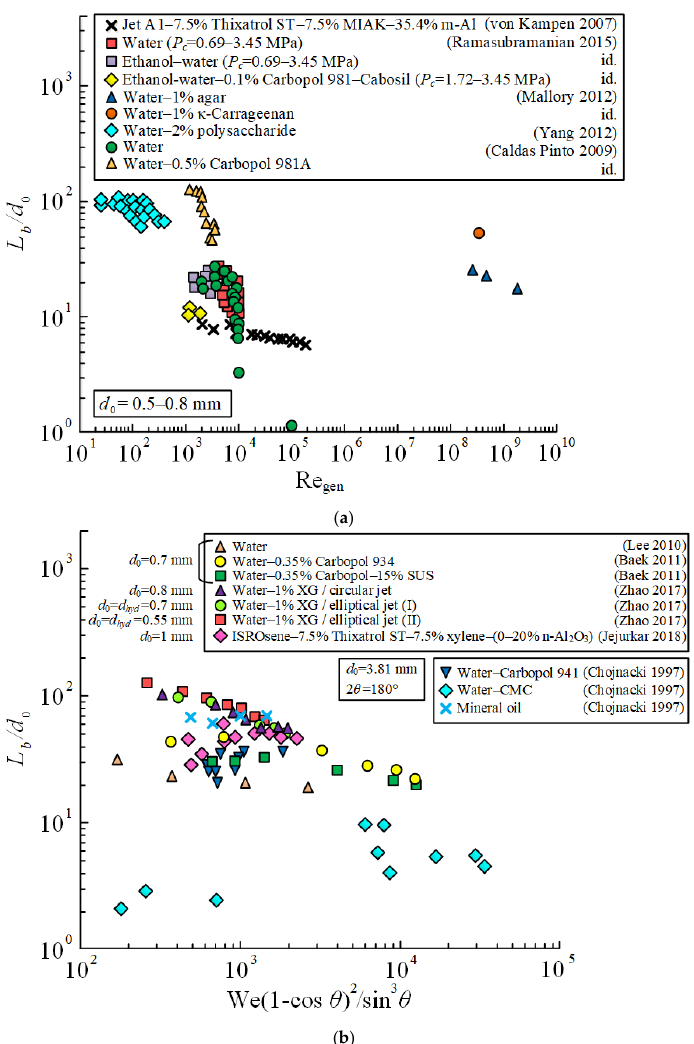
Figure 12. The breakup length of gel fuels and their simulants when flowing through a two-jet atomizer, depending on the: ( a ) Reynolds number [65,143,144,150,168,171]; ( b ) Weber number [68,69,149,167,170]. Under the conditions of vortex spraying of gel fuels, four typical regions were iden- tified [172] along the flow breakup length (Figure 13): I—intact hollow conical sheet; II—